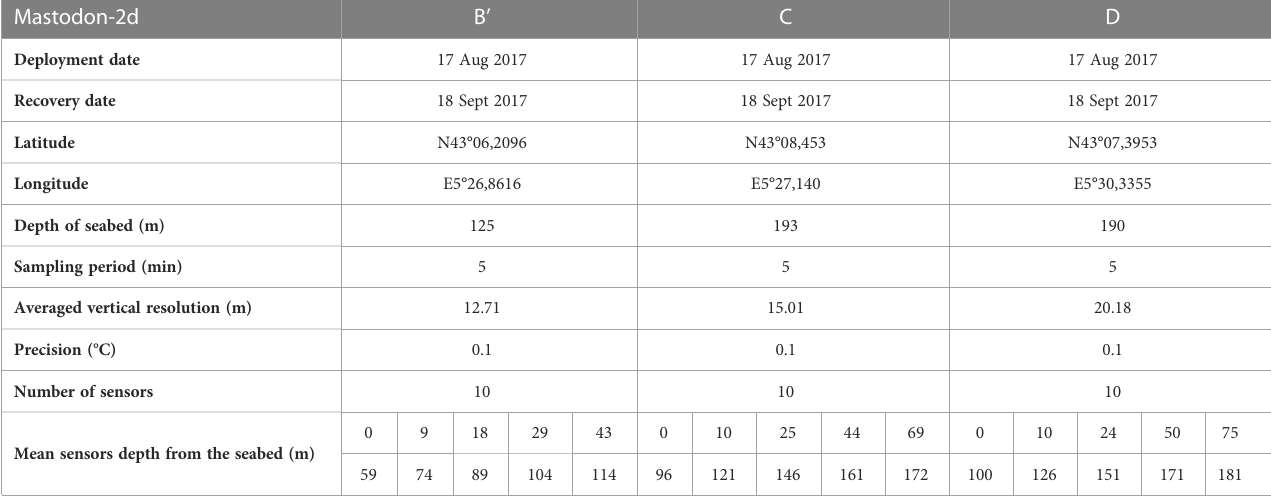
TABLE 2 Position and setting of the thermistor lines and pressure and temperature sensors of each Mastodon-2d used during the UPCAST 2017 cruise. Mastodon-2d B